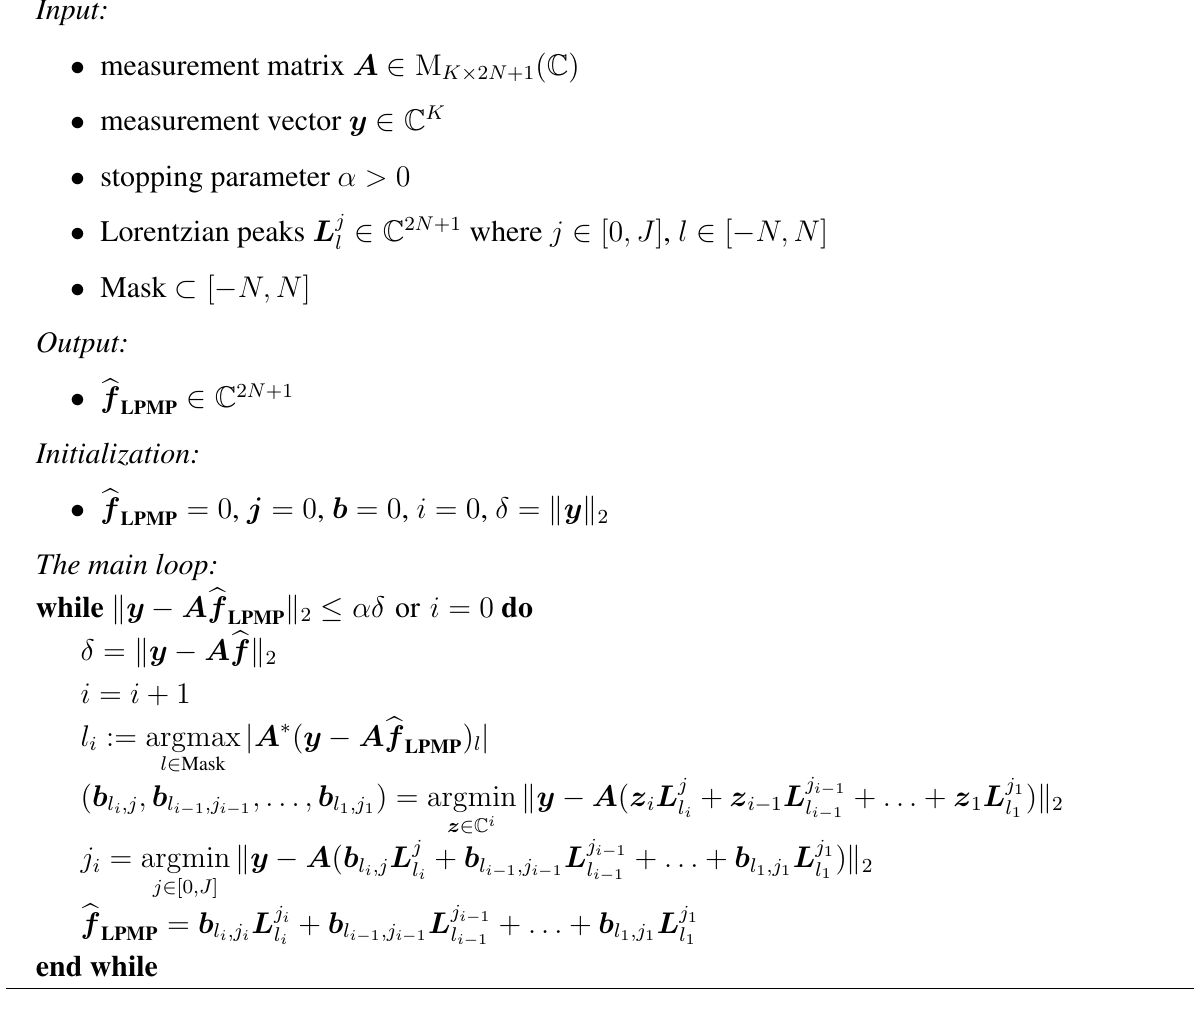
Algorithm 3 Lorentzian peak matching pursuit with a